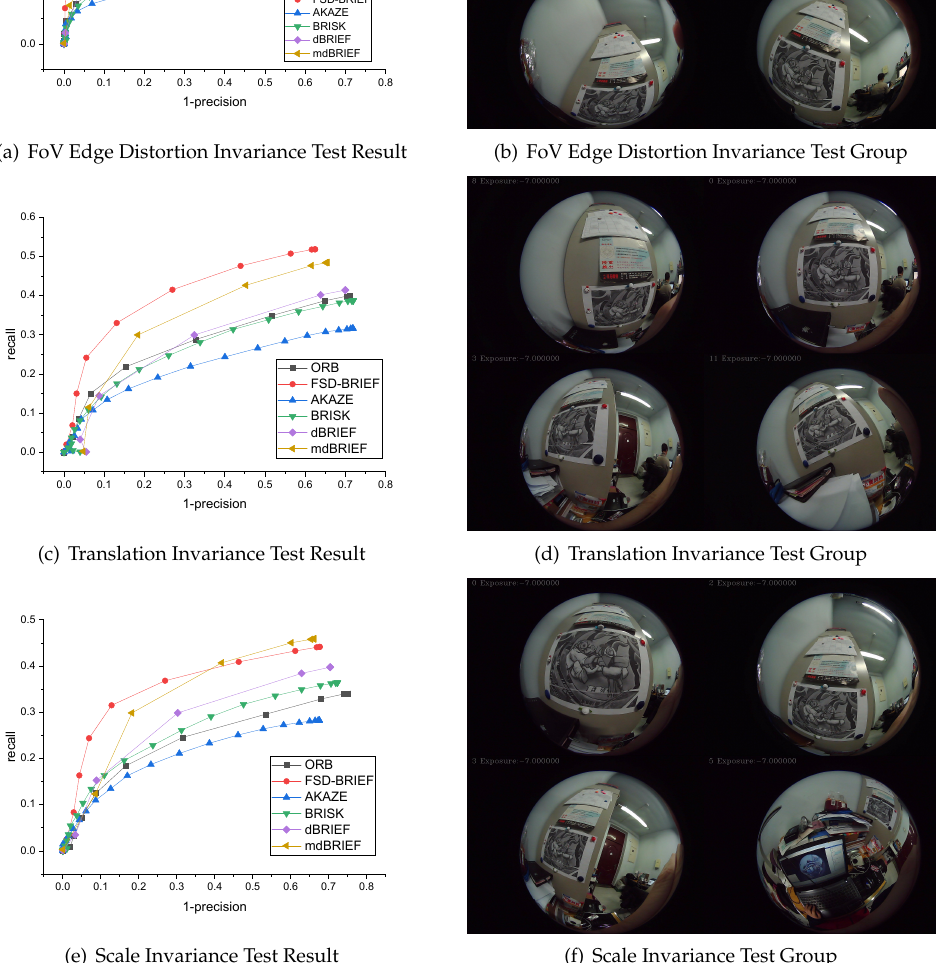
Figure 13. 210 ◦ FoV camera dataset and corresponding PR curve